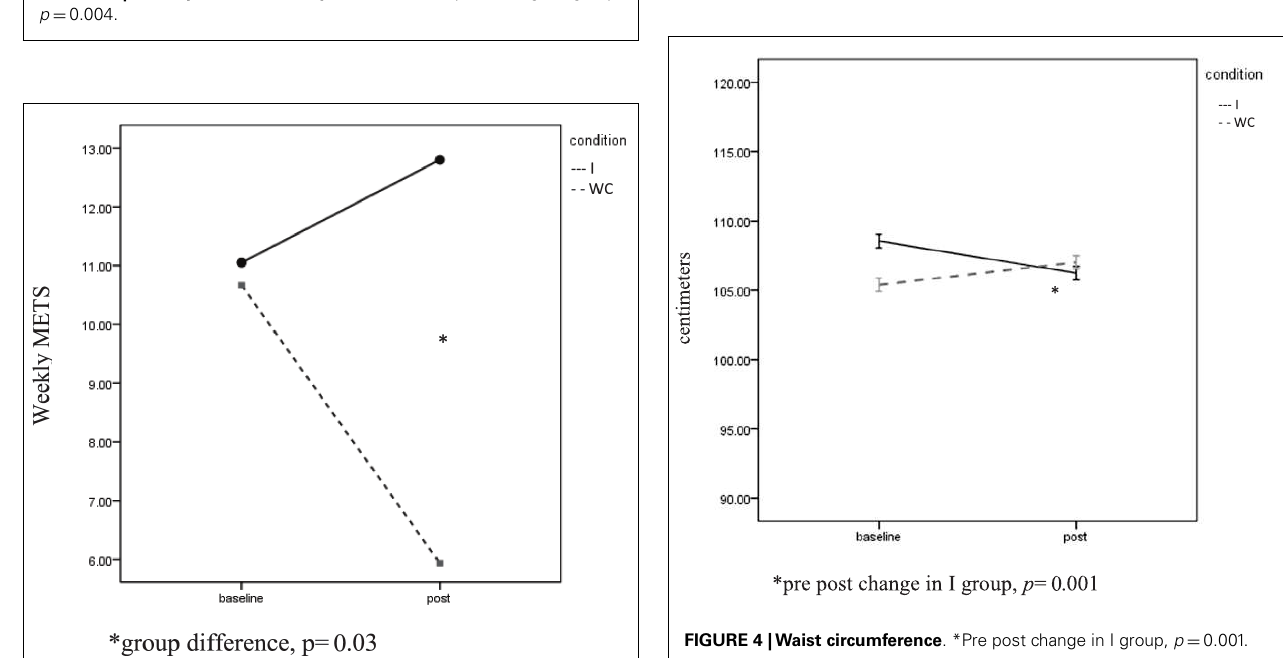
FIGURE 4 |Waist circumference . *Pre post change in I group, p =